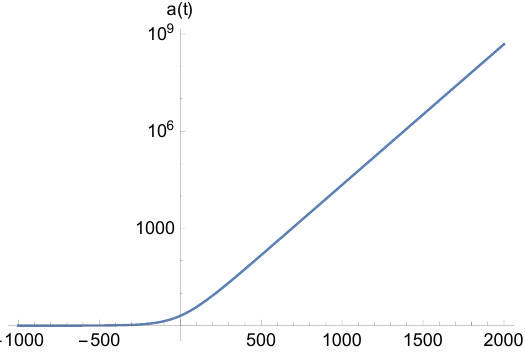
Figure 1. Scale factor evolution with A = 1 and H 0 = 0.01.